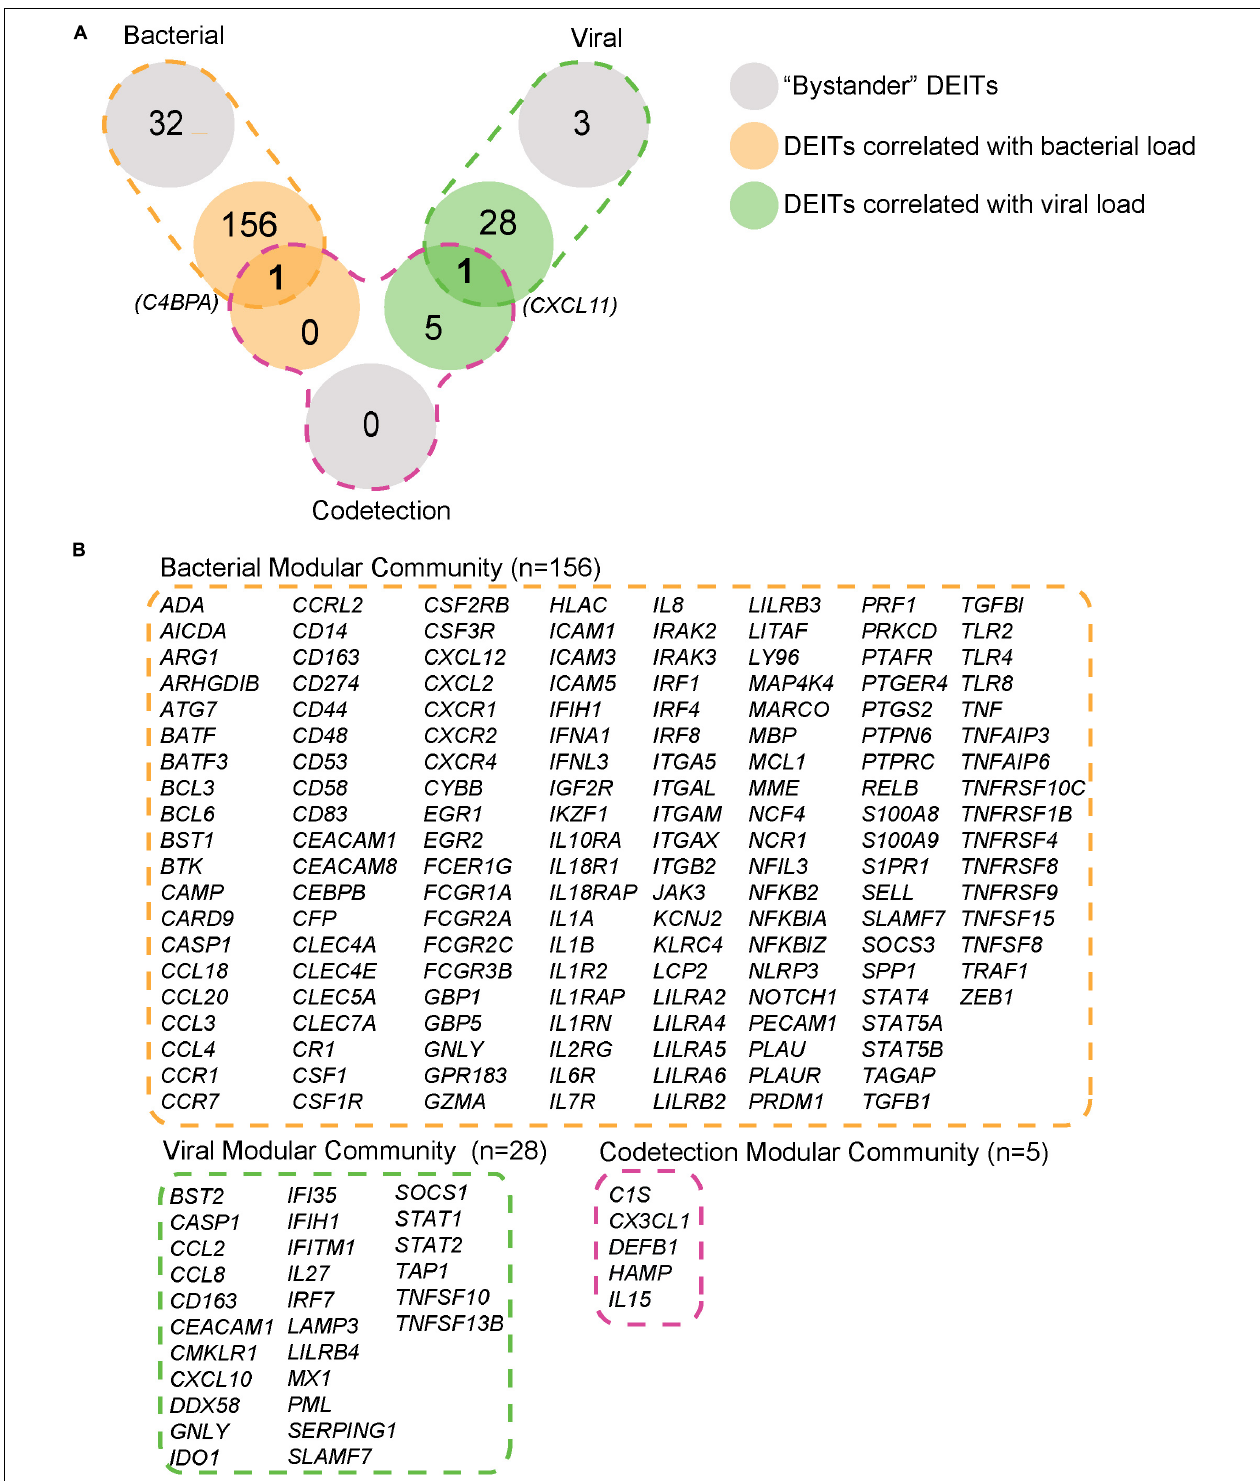
FIGURE 3 | Modules of immune genes differentially expressed in nasopharyngeal aspirates of children with ARI. The correlation between DEITs (differentially expressed immune transcripts) and microbial load in NPAs classified as bacterial (orange) or viral (green) were determined by Spearman ( p < 0.05) and correlation strength was assessed by non-parametric bootstrap. The DEITs with bootstrap values > 50% were subjected to modularity analysis (see Materials and Methods for details). (A) Numbers within the orange or green circles represent genes with similar modularity. Numbers within gray circles represent genes with different modularities. (B) Modular communities of DEITs correlated with bacterial, viral, or codetection (bacterial + viral) load.